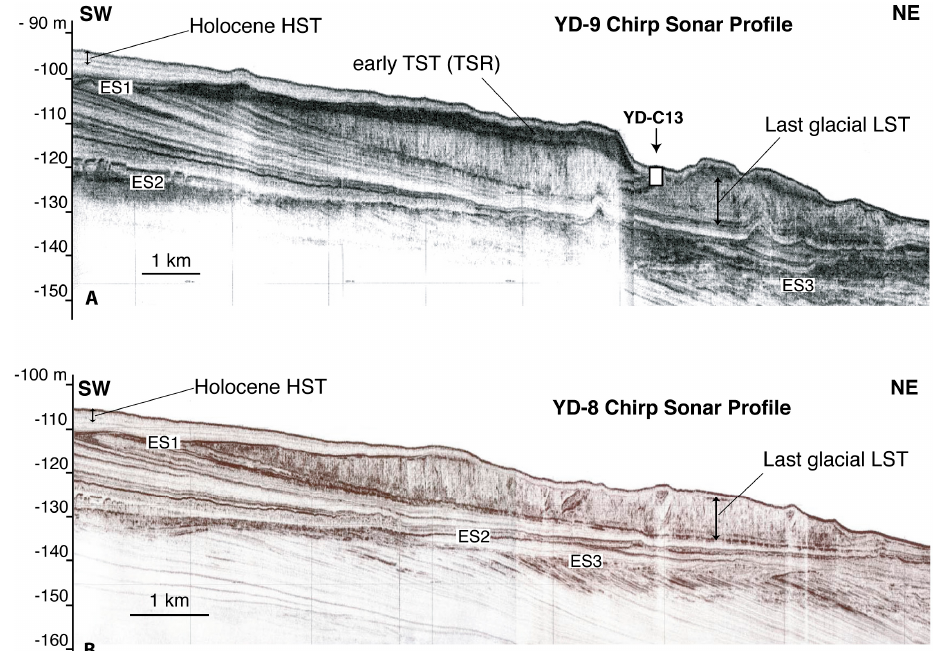
Figure 4. Seismic profiles YD-9 ( A ) and YD-8 ( B ) show the last glacial LST on the South Adriatic outer shelf (modified from [56]; location in Figures 1 and 5). This corresponds to the most distal progradational unit within sequence 1 (encompassed by ES1 and ES2), formed at the end of the last glacial sea level fall. This shelf edge LST consists of a lenticular wedge with a patchy distribution (Figure 5), rapidly passing to a thin draping veneer at depths greater than 130–140 m. Note the opaque seismic facies, sharp basal contact and erosional top surface (with channel incision in YD-9), indicating marine erosion and reworking. An early TST unit is present only in YD-9 seismic profile ( A ), which correlates with deposits to the south interpreted as transgressive sand ridges (TSR). The absence of this unit in YD-8 seismic profile ( B ) marks the northern limit of the TSR distribution area. The target of core YD-C13 is also reported (compare with Figures 5–7).